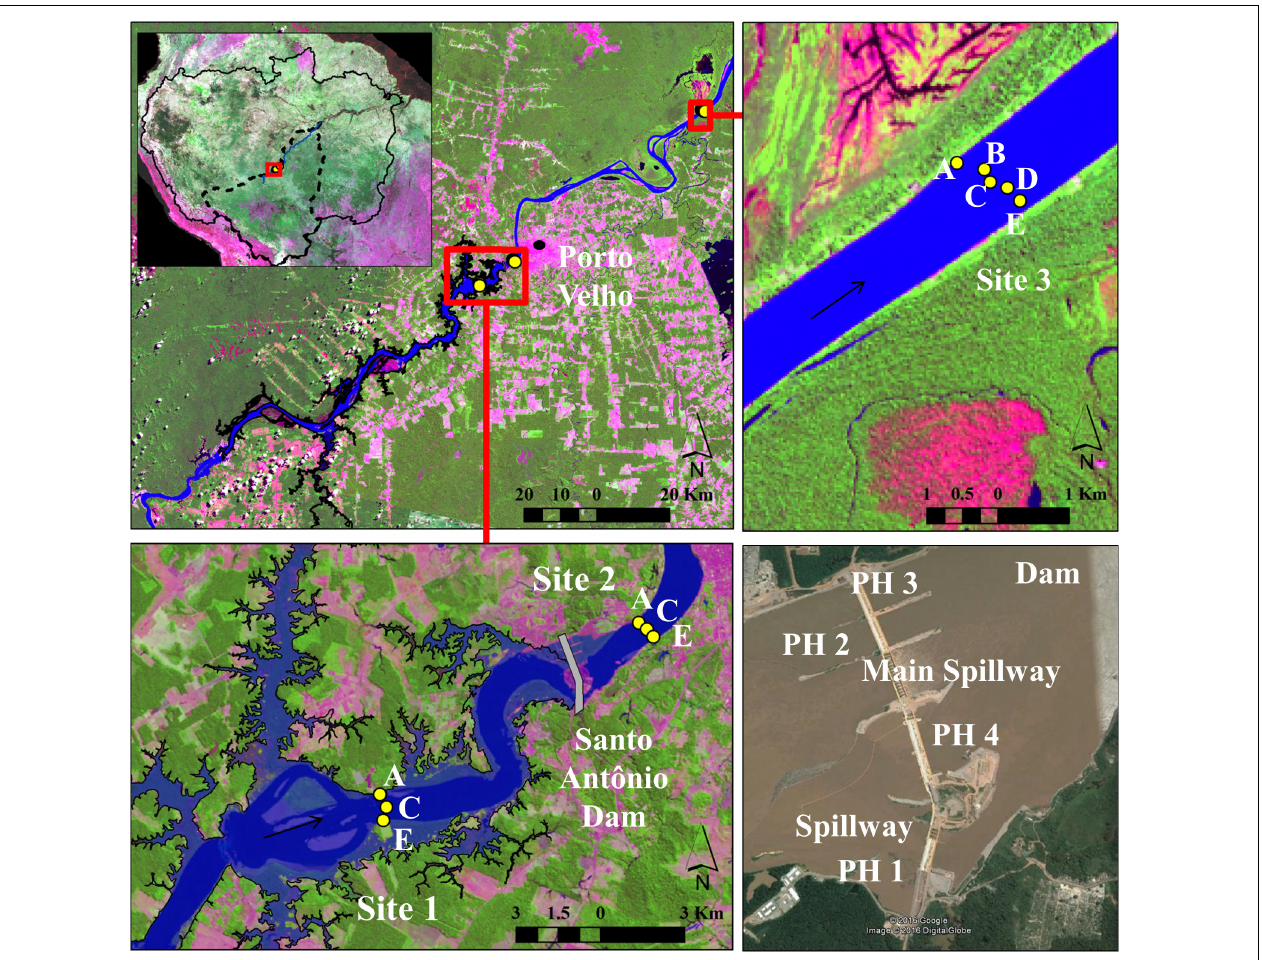
FIGURE 1 | Sampled sites in the Madeira River showing the cross-channel stations. Arrows show the flow direction. The shaded blue area shows the area flooded by the reservoir. The main background image is Landsat 8, acquired on July 10, 2013, available from USGS (https://landlook.usgs.gov/landlook/). The Santo Antônio Dam in the bottom right corner shows the Powerhouses (PH) were turbines are installed and spillways, image from Google